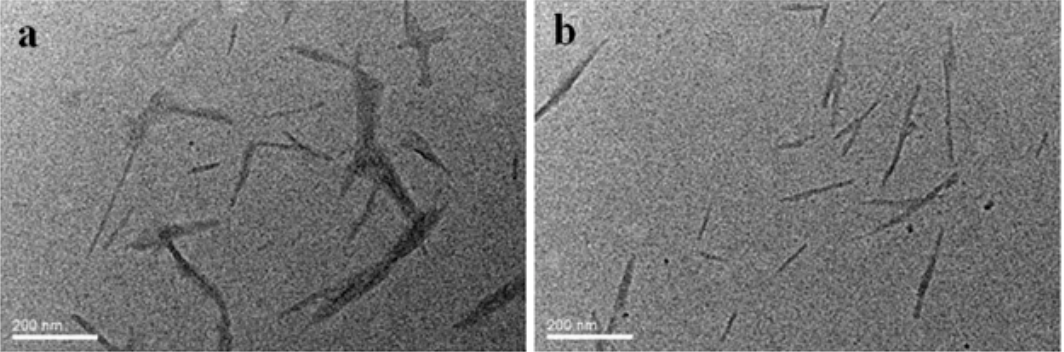
Figure 1. TEM images for ( a ) nanocrystalline cellulose (NCC) and ( b ) cationically modified NCC (CNCC).